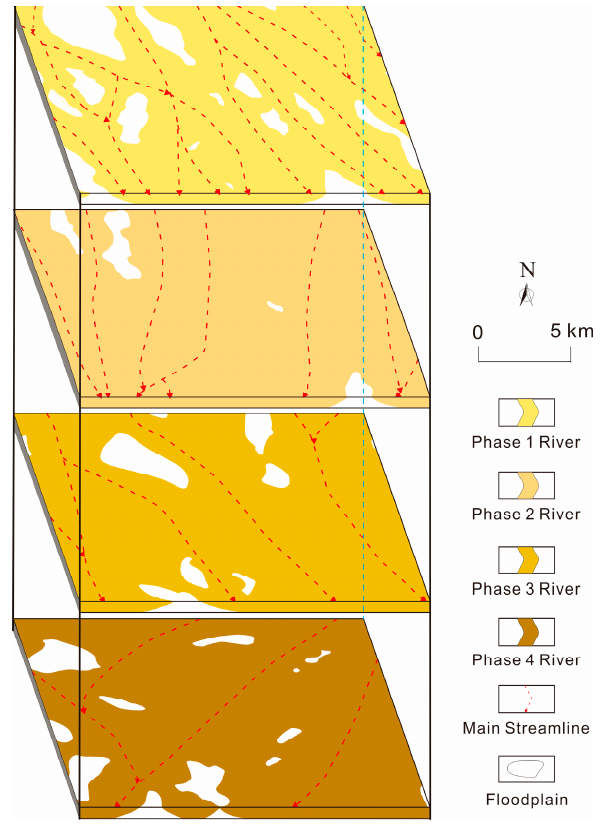
Figure 4. Distribution of braided river deposits in H1 member of Lower Shihezi Formation.